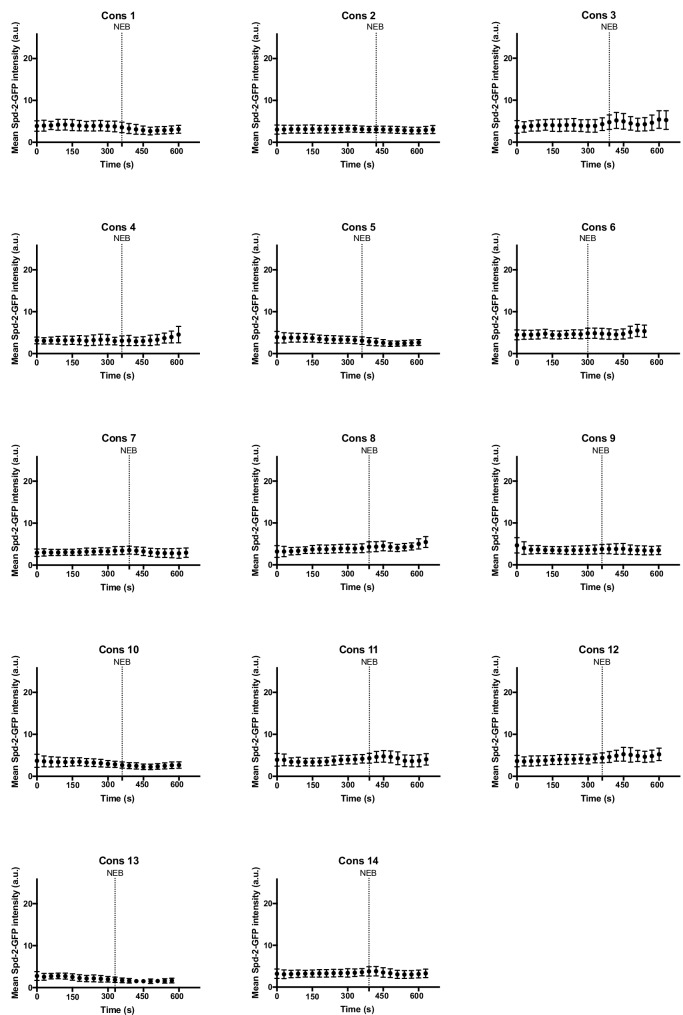
Centrosome maturation dynamics in Spd-2 mutant embryos rescued by Spd-2-GFP-CONS.Graphs show the mean ± SD centrosomal Spd-2-CONS-GFP intensity (in arbitrary units [a.u.]) through an entire embryonic cell cycle (nuclear cycle 12) for 14 different Spd-2-CONS-GFP embryos. Number of centrosomes analysed per embryo = 44–124. Time (s) is indicated; t = 0 was set as the time that centrosomes first separated at the start of S-phase. Dashed lines indicate nuclear envelope breakdown (NEB).